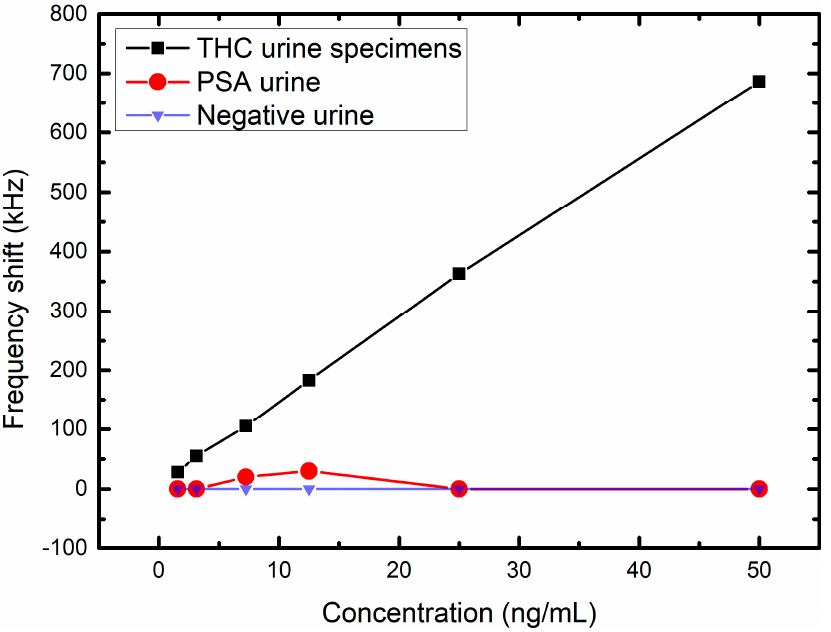
Figure 9. Measurement results of the THC urine specimens, PSA urine, and negative urine.